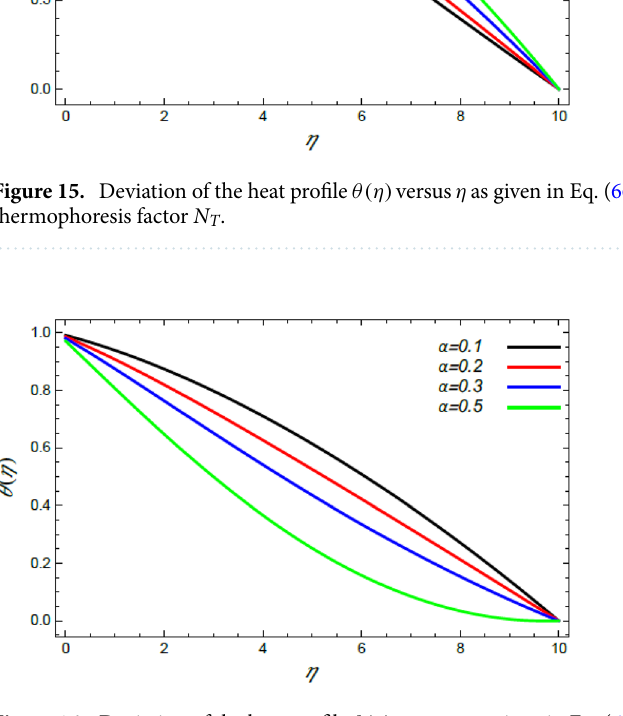
Figure 16. Deviation of the heat profile θ(η) versus η as given in Eq. (66) to illustrate the impact of the stretching factor α .